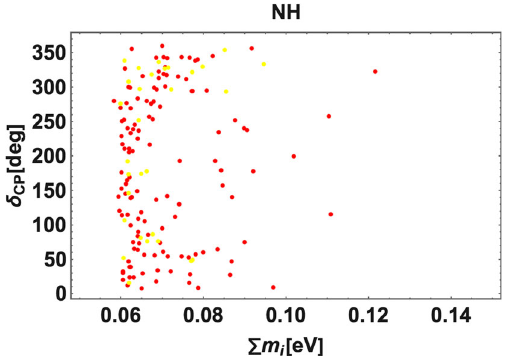
Fig. 3 Allowed region of δ CP in terms of